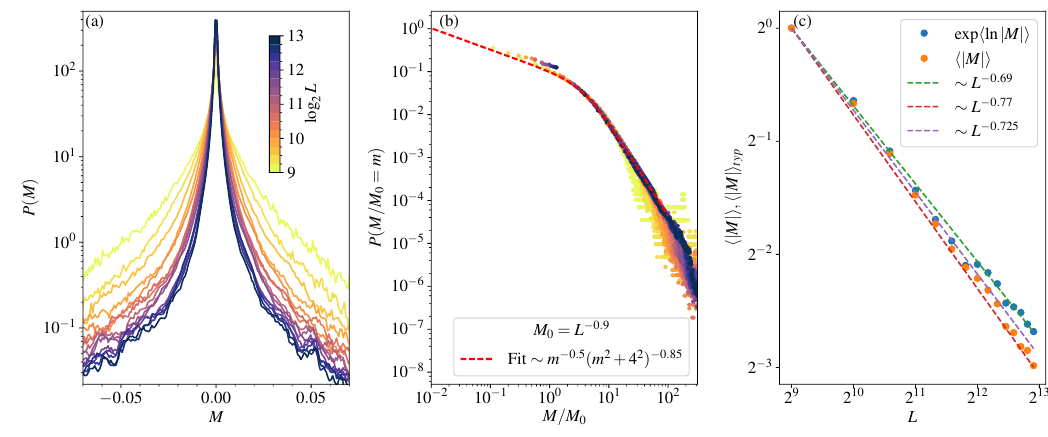
Figure 8: Probability distribution of M . (a) P ( M ) calculated from the distribution of the elements in Eq. (11) for different L (denoted by the color scale) is not Gaussian. (b) The ) with the corresponding polynomial fit (see legend collapsed probability distribution P ( M / M 0 ] (typical) with L . Dashed lines for details). (c) The scaling of 〈| M |〉 (mean) and exp [ 〈 ln M 〉 P P of the corresponding colors show fits with algebraic decay with exponents ≈ 0.78 and ≈ 0.69, respectively. The algebraic decay ∼ L − ( 2 − D ) with D = 0.55 ± 0.04 expected from multifractal analysis is shown by a black dashed line. Parameters are the same as in Fig. 2. (cid:39) 4, c = a − b / 2, and a (cid:39) 1.1 for ν = 0.9 (see Fig. 8(b)). This gives b (cid:39) 0.5, m 0